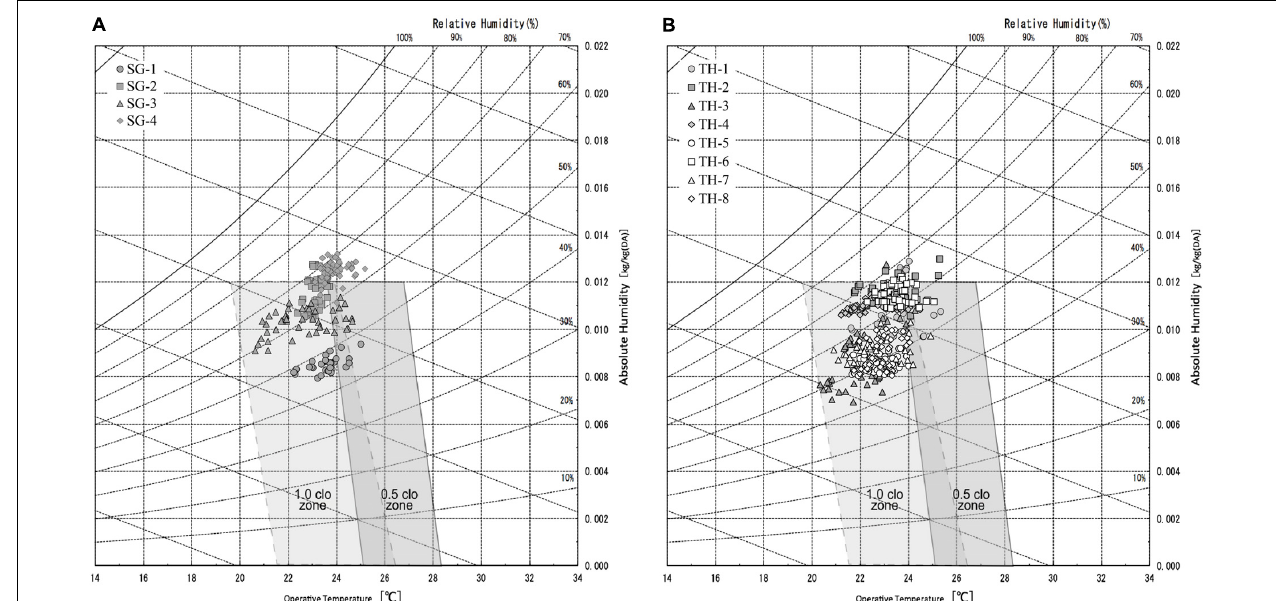
FIGURE 1 | Indoor thermal environments of the case studies on a psychometric chart of the ASHRAE 55 standard: (A) Singapore and (B) Thailand.